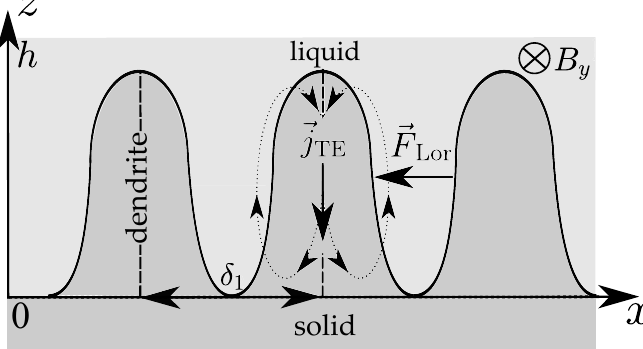
Figure 4. The problem geometry under the horizontal static